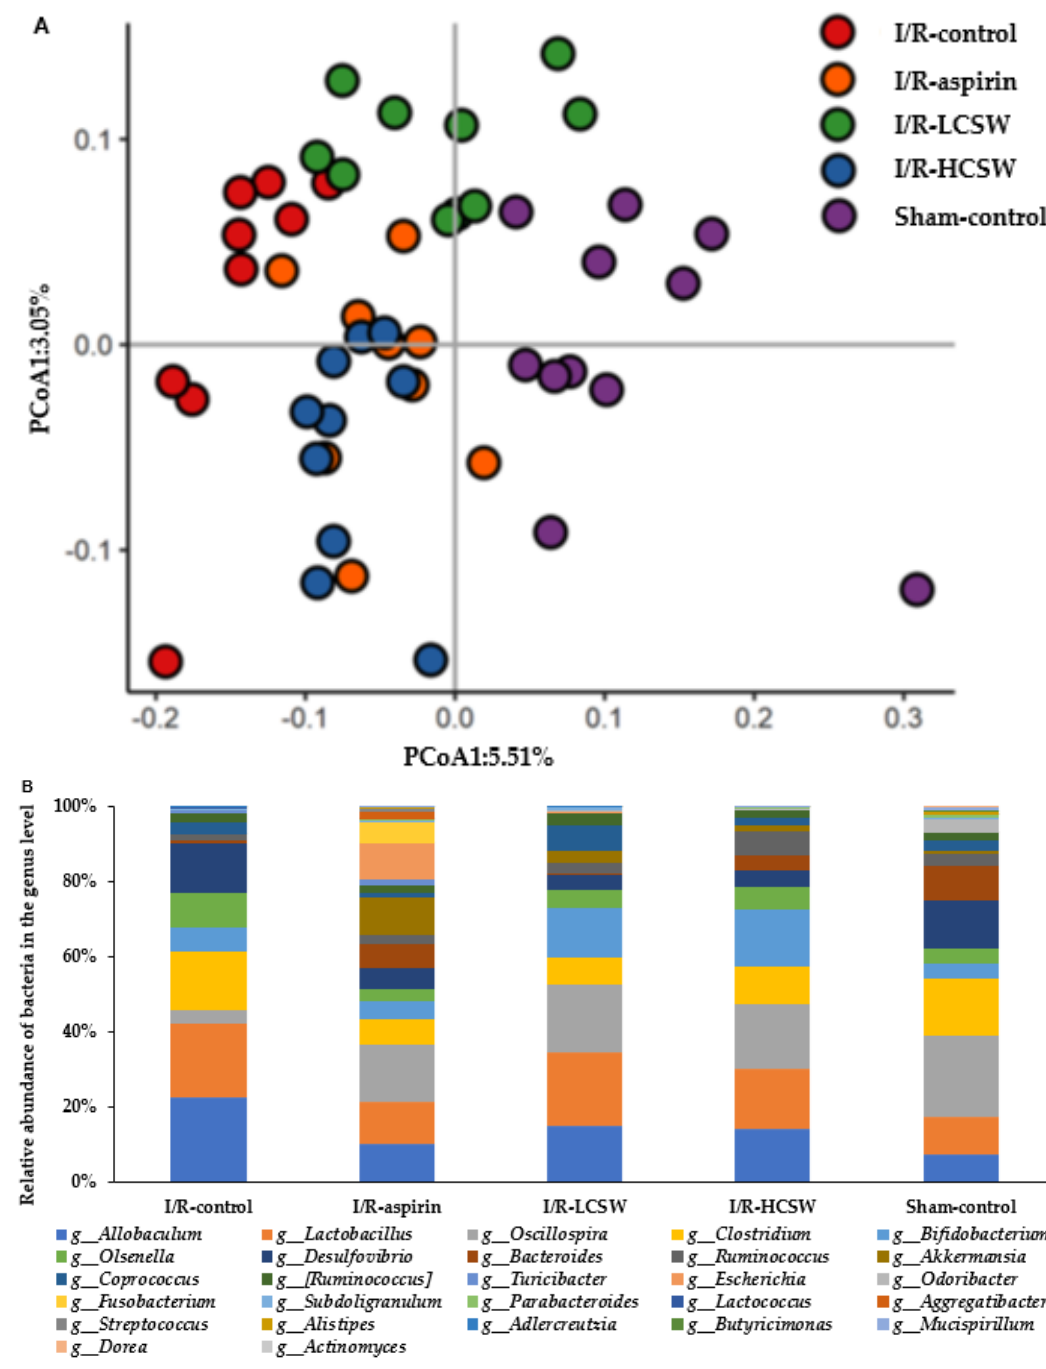
Figure 5. The profiles of gut microbiomes. Gerbils that underwent the transient ischemic attack by carotid artery occlusion for 8 min and reperfusion were randomly divided into four groups, as follows: (1) 0.2% cellulose (I/R-control), (2) 0.02% aspirin (I/R-aspirin), (3) 0.05% freeze-dried corn silk water extract (I/R-LCSW), and (4) 0.2% CSW (I/R-HCSW) in a high-fat diet. Sham-operated gerbils without artery occlusion had the same diet as Sham-control. At the end of the experimental period, feces from the cecum were collected, and the bacterial DNA was analyzed. The β-diversity was analyzed by the principal coordinate analysis (PCoA) of the fecal bacterial community ( A ), and the relative abundance of bacteria at the genus level ( B ) was calculated. Bars represent means ± SD ( n = 10). relative abundance of Lactobacillus , Bifidobacterium , and Allobaculum was lower in the I/R- control group than the Sham-control group (Figure 5B). In contrast, it was higher in the CSW groups. The relative abundance of Akkermansia was higher in the I/R-aspirin and CSW groups. The relative abundance of Clostridium , Desulfovibrio , and Oscillospira was higher in the I/R-control group than the-Sham-control group and was suppressed by CSW intake. The Akkermansia proportion was higher in the I/R-aspirin and I/R-CSW groups (Figure 5B). In metagenome analysis with Picrust2, propionate metabolism was similar in the I/R- control and Sham-control groups, while CSW and aspirin intake showed a more robust propionate metabolism (Table 5). The butyrate and starch metabolisms were much lower in I/R-control than Sham-control, while higher in I/R-CSW and I/R-aspirin, similar to Sham-control (Table 5). LPS biosynthesis was much higher in the I/R-control group than the Sham-control group, and CSW intake decreased LPS biosynthesis (Table 5). 4. Discussion The present study showed that an artery occlusion for 8 min. in male gerbils induced global ischemia in the brain, while CSW intake alleviated the neuronal cell death, memory deficit, and clinical ischemic stroke symptoms. These observations are related to the re- duced proinflammatory cytokines and post-stroke hyperglycemia involved in the gut mi- crobiome changes with CSW intake. The present study is the first to demonstrate the ef- fects of CSW on alleviating ischemic stroke and the involvement of CSW in gut microbi- ome alteration. CSW is rich in flavonoids and has redox activities that act as both anti- and pro-oxidant [30]. However, they mainly act as antioxidants in normal tissues to remove